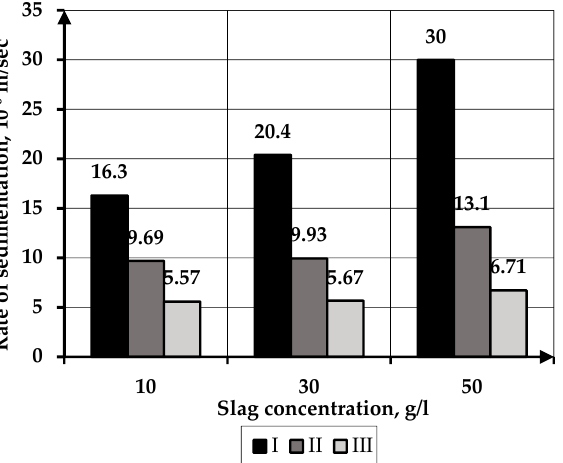
Figure 11. Dependence of the particle sedimentation rate on the slag concentration in water-polymer dispersed medium.